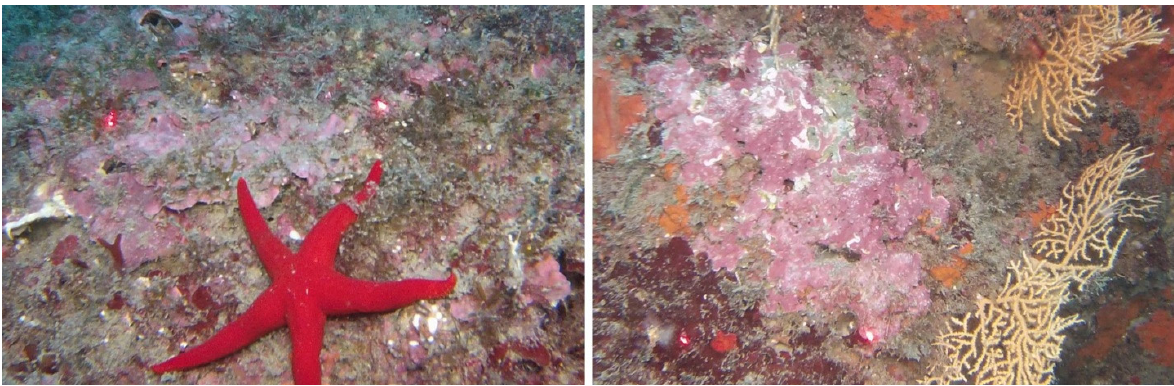
Figure 9. Two frames derived from ROV videos, showing a high coverage of encrusting Rhodophyta.